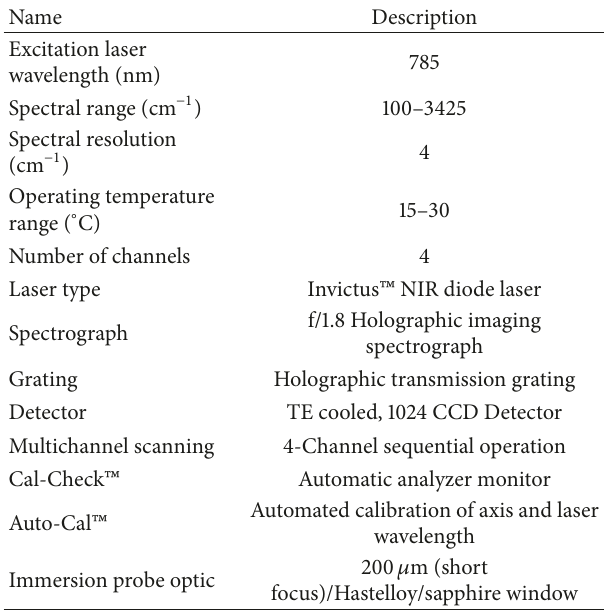
Table 1: Specifications of the RXN2 Raman